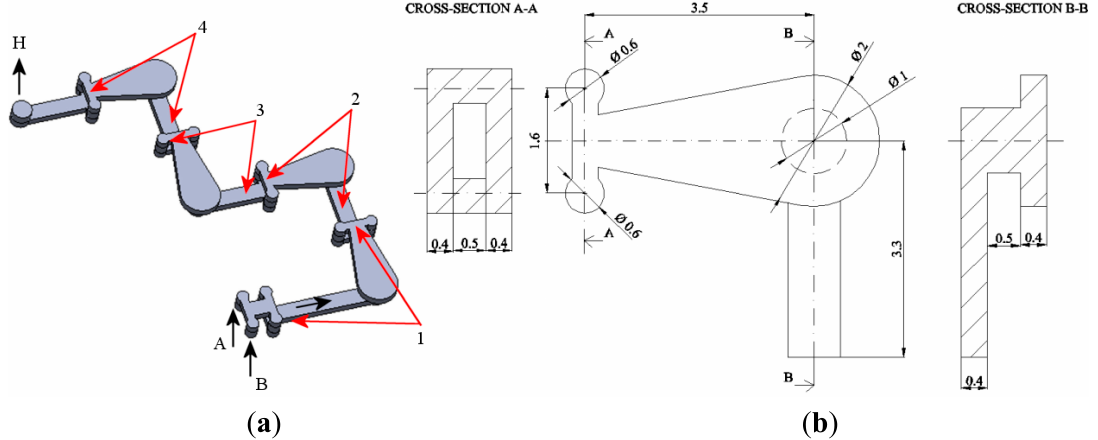
Figure 3. Geometry of the H-C micromixer (dimensions in mm): ( a ) three-dimensional view; ( b ) top view of one element and cross-sections.